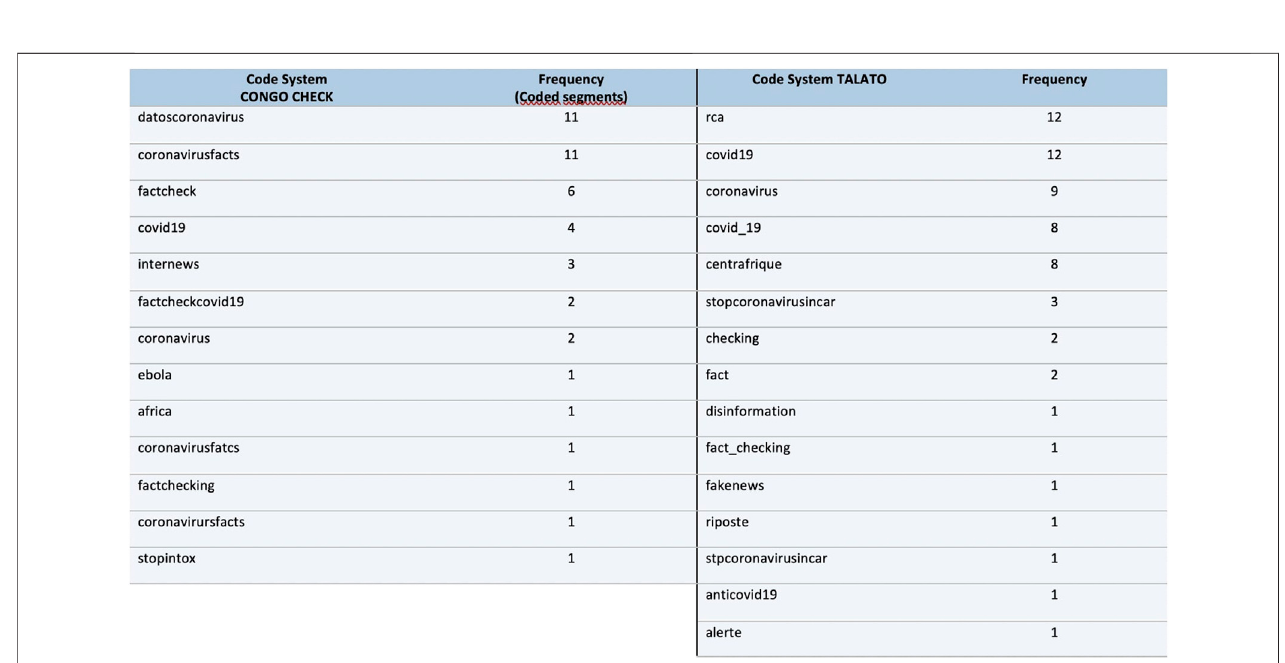
FIGURE 10 | Code system of Congo Check and